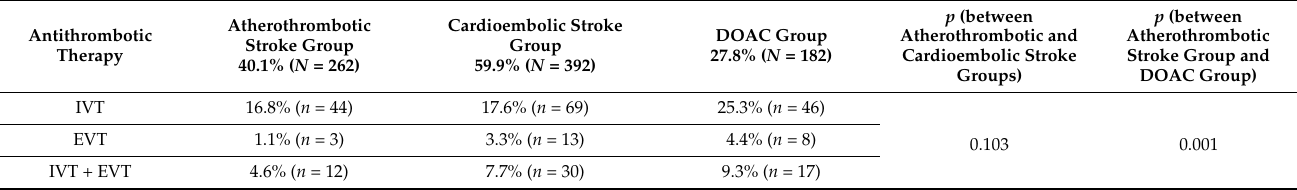
Table 1. The patients’ treatment data.